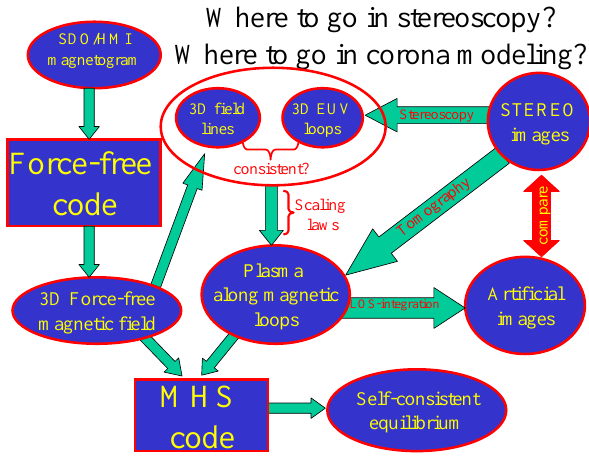
Fig. 9. A concept on how stereoscopy could be imbedded in a self-